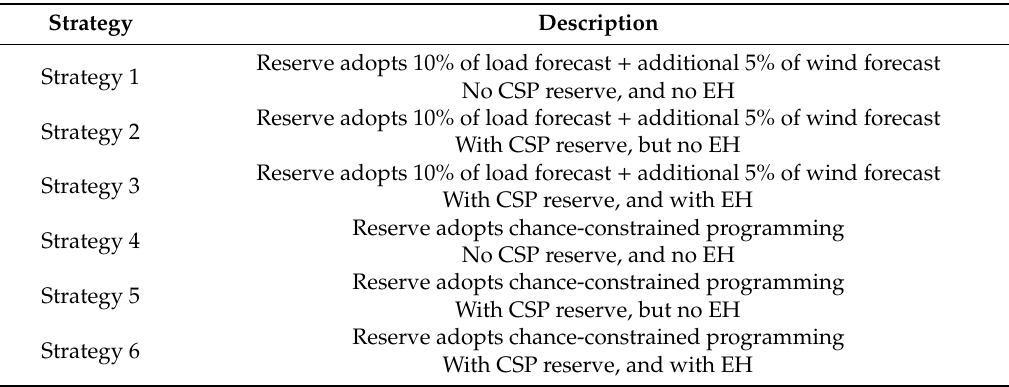
Table 5. Di ff erent reserve strategies.